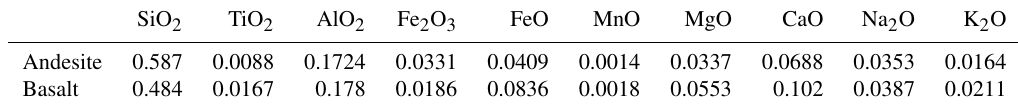
Table D1. Oxide compositions for the magmas used in benchmarking simulations. Amounts are